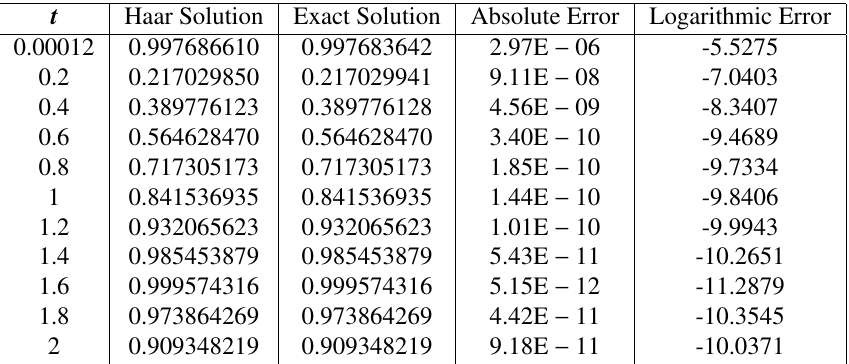
Table 2. Numerical results , exact solutions and errors for Example 1 for J =